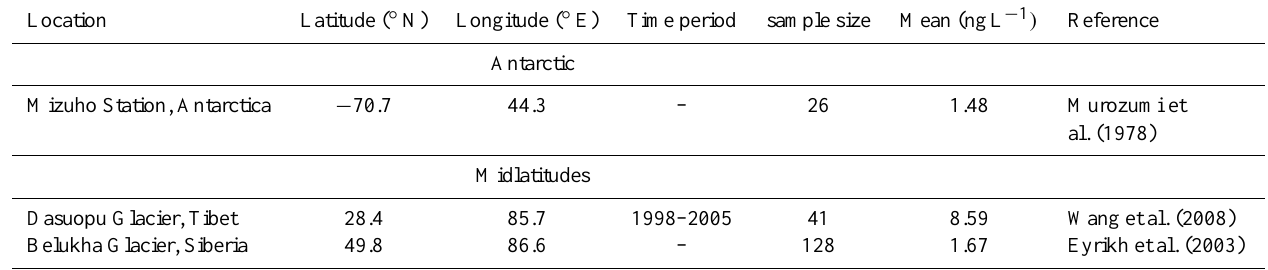
Table 6. Mean concentrations of total mercury in long-term snowpack-related records that were not included in Durnford and Dastoor (2011). Location Latitude ( ◦ N) Longitude ( ◦ E) Time period